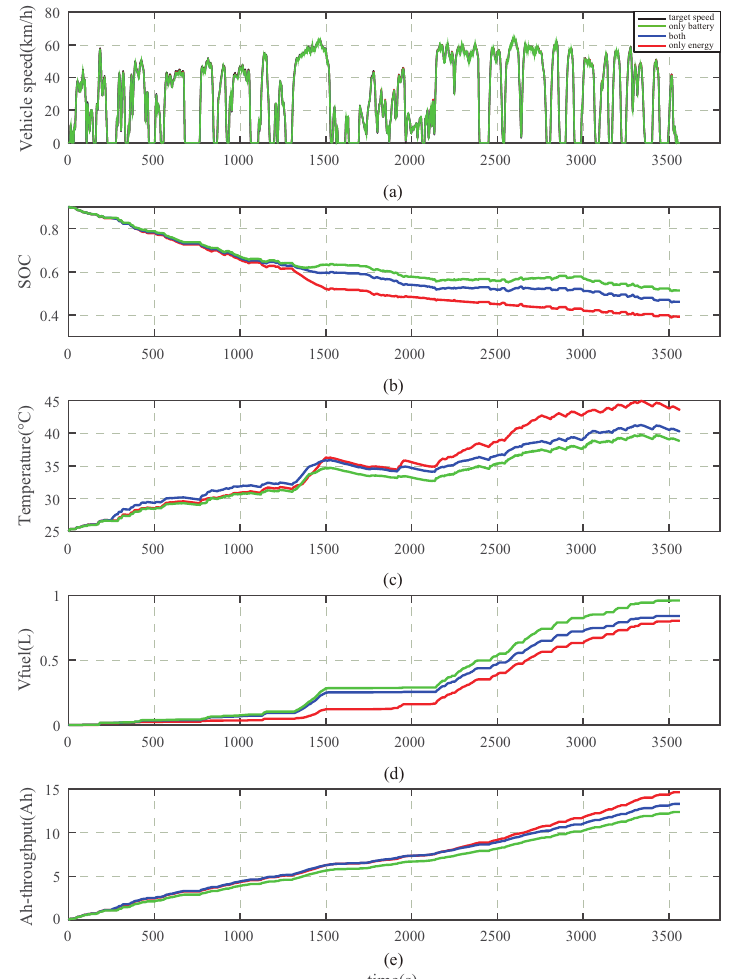
Figure 12. Comparison of the energy consumption considered alone, both considered and the battery health considered alone in the second week Thursday speed profile. ( a ) Vehicle speed. ( b ) SOC. ( c ) Battery temperature. ( d ) Energy consumption. ( e ) Effective